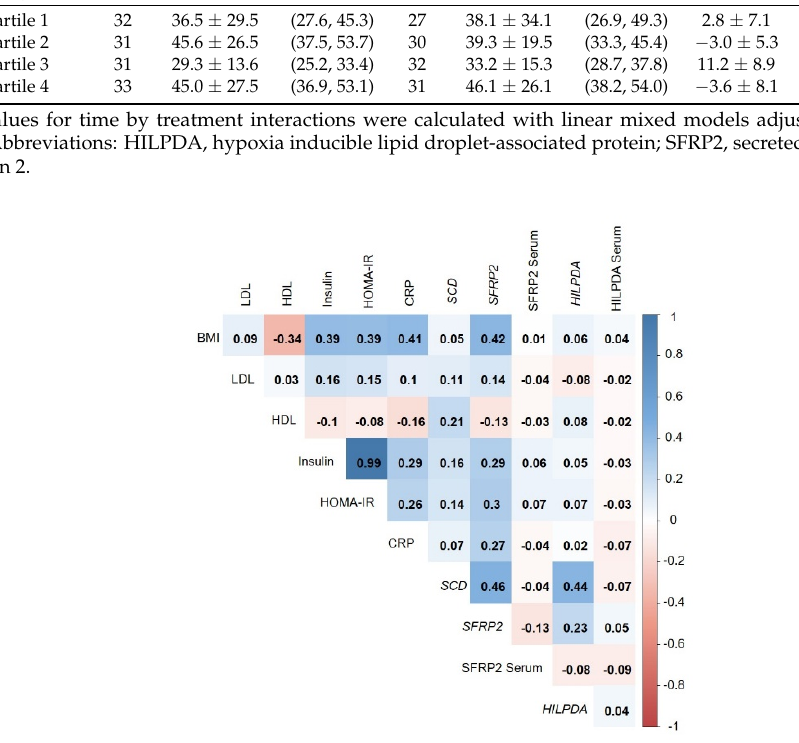
Figure 3. Cross-sectional correlations (at Week 12) between SCD , SFRP2 , and HILPDA microarray gene expression levels, serum levels of SFRP2 and HILPDA, BMI, and metabolic biomarkers (LDL, HDL, insulin, HOMA-IR, CRP). Data are shown as Spearman coefficients adjusted for age and sex. The cross-sectional correlations for baseline data and for log relative changes between baseline and Week 12 are shown in Figure S2.